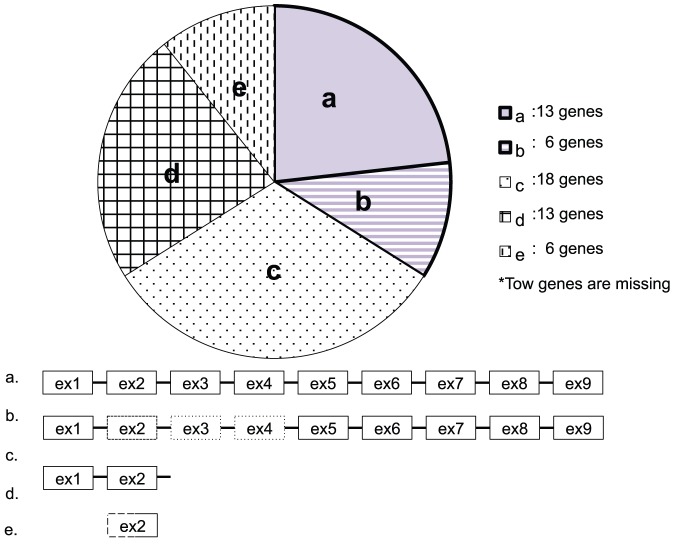
Categorization of the 58 human CYP pseudogenes.Among the 58 pseudogenes, paralogs were detected by a BLAST search. a. The number of exons and introns is the same as in the paralogous genes (13 genes), b. They contain greater than half the number of exons and introns of their paralogs (6 genes), c. One or two exons or introns remained (18 genes), d. A portion of an exon remained (13 genes), e. The BLAST search returned no hits (6 genes). *Two pseudogenes were absent from the human genome databases. Approximately one-third (a and b) of the human CYP pseudogenes were used for phylogenetic analysis.